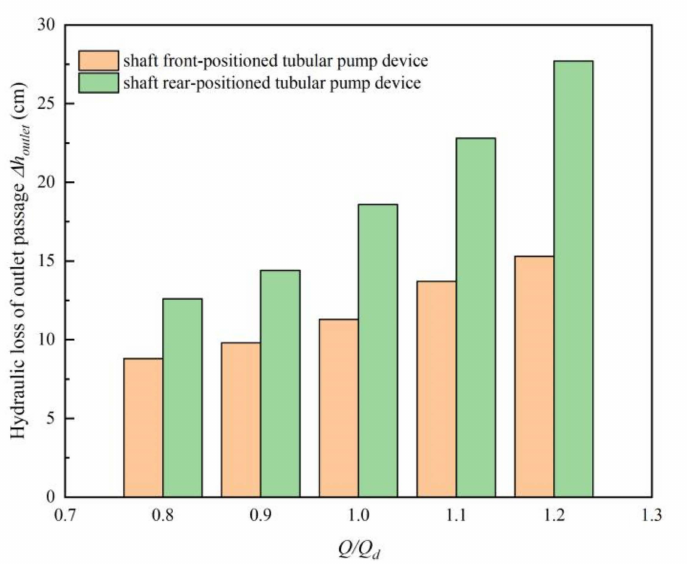
Figure 12. Hydraulic loss of outlet